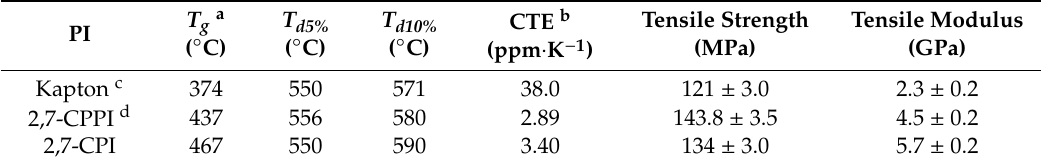
Table 1. Thermal and mechanical properties of the 2,7-CPI film.